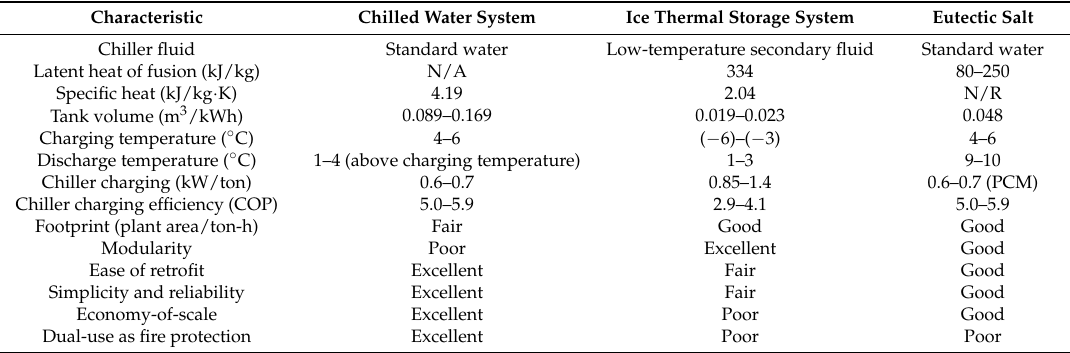
Table A2. Characteristics of typical CTS systems suitable for building air-conditioning